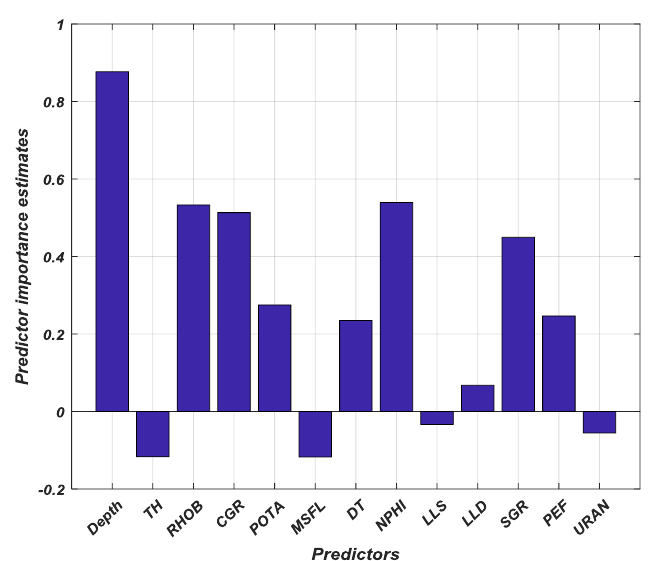
Figure 2. Full set well logging data